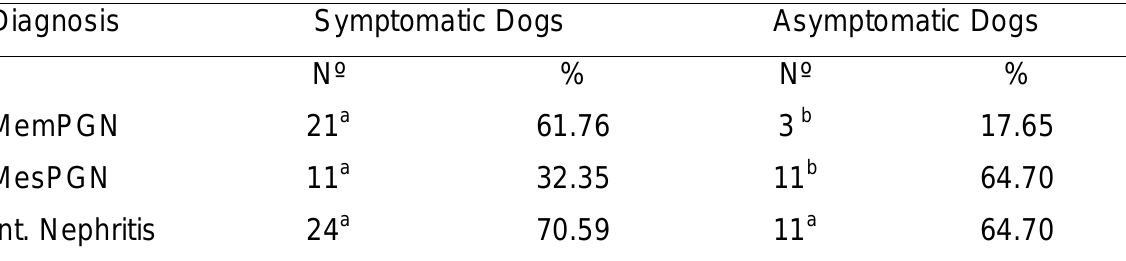
Table 5: Result of renal histological evaluations of symptomatic (n=34) and asymptomatic (n=17) nonazotemic VL seropositive dogs from Teresina, Piauí State, Brazil,